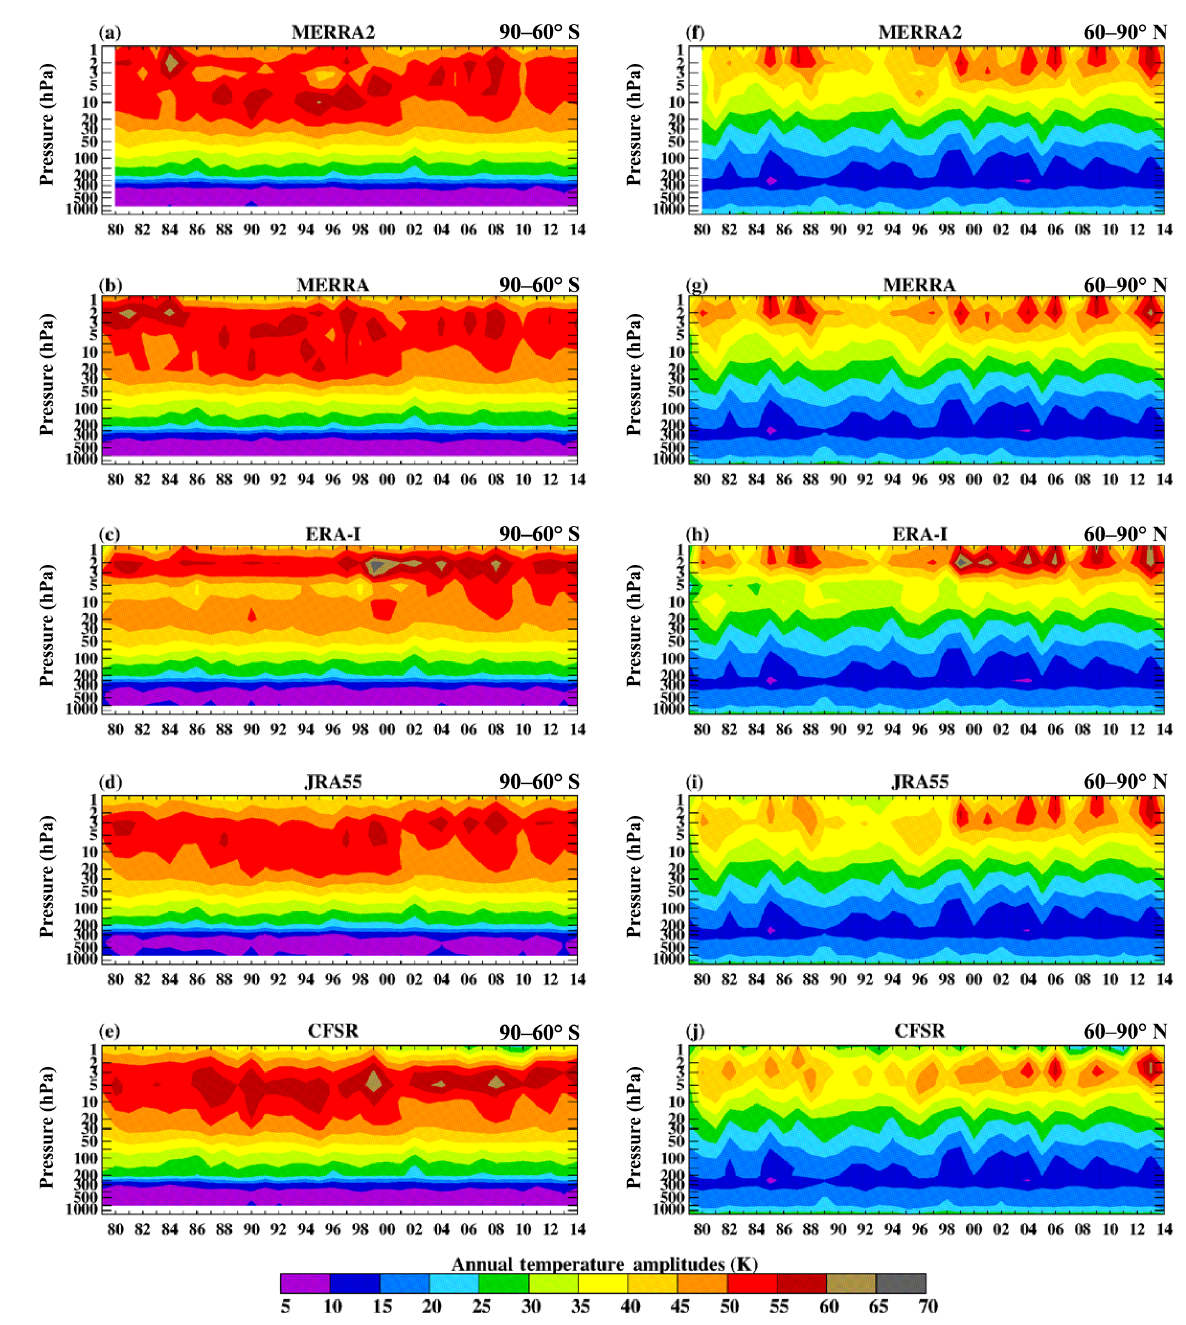
Figure 11. Yearly annual temperature amplitude (K) for 90–60 ◦ S (a–e) and 60–90 ◦ N (f–j) from the (a, f) MERRA-2, (b, g) MERRA, (c, h) ERA-I, (d, i) JRA55, and (e, j) CFSR reanalyses. Note that the SH annual amplitude is much larger than the NH amplitude. No analysis is performed between 1000 and 700hPa for the SH plots as this is below the Antarctic surface.